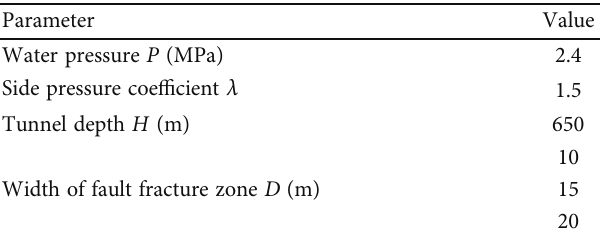
Table 5: Calculation parameters for the width variation of fault fracture